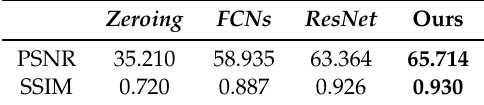
Table 1. Performance Comparison with the Simulated Radar